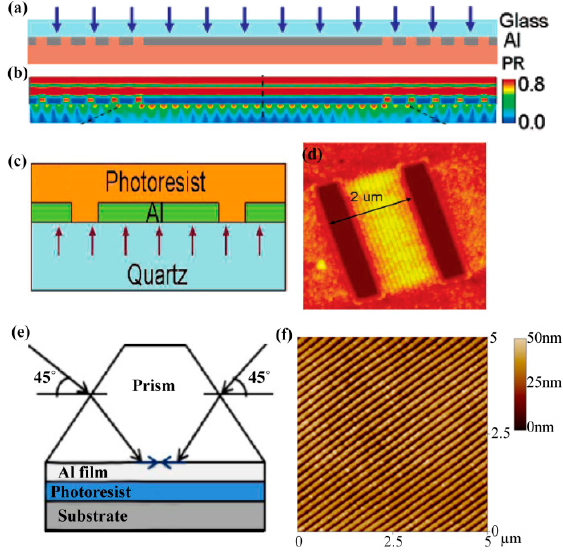
Figure 7. ( a ) Schematic structure of grating excited SPPs’ interference lithography; ( b ) Simulated electric field intensity distribution; ( c ) Resist recording results of SPPs’ interference fringes. Reproduced from [21], Copyright © 2004, AIP.